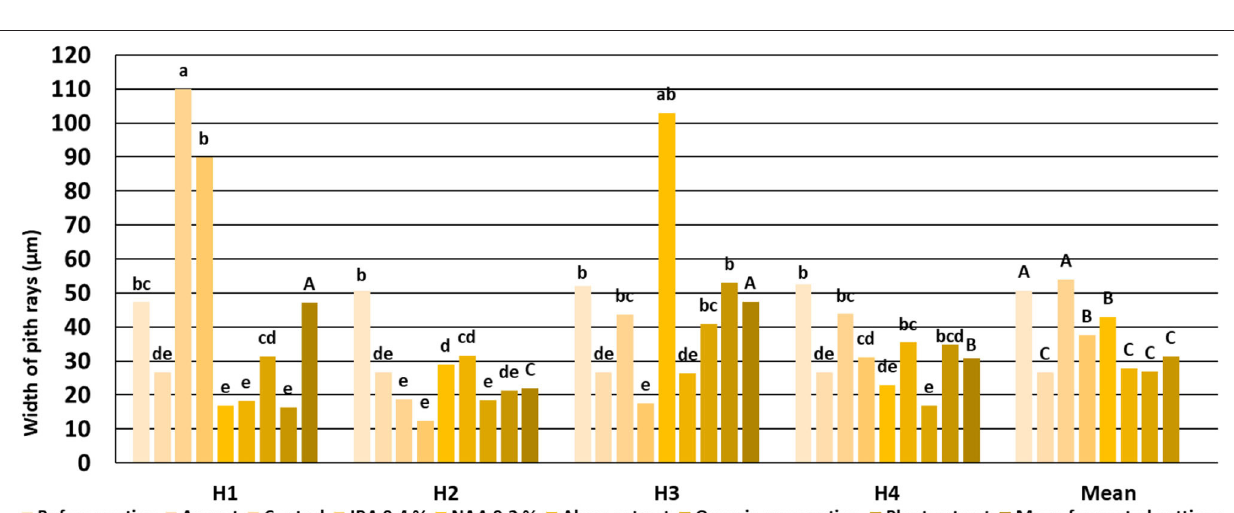
FIGURE 5 | Width of Rosa “Hurdal” pith rays in stems before rooting; cuttings after 24 days of the rhizogenesis process; and stems of stock plants cut in first days of August. Control—the control cuttings; IBA, 0.4%—Ukorzeniacz A aqua (0.4% IBA); NAA, 0.2%—Ukorzeniacz B aqua (0.2% NAA); Algae extract—watering with 0.6% Bio Rhizotonic (10ml) after planting and 10 and 20 days later; Organic preparation—watering with 0.4% Root Juice TM (10ml) after planting; Plant extract—watering with 0.02% Bio Roots (10ml) after planting. H1 − 54 504 (flower buds still closed); H2 − 69 605 (full flowering; at least 50% of flowers open); H3 − 69 629 (end of flowering of the second-order stem—all petals have fallen); H4 − 70 701 [fruit set: beginning of hip (berry) growth on the main stem]. Different small letters indicate significant interactions between the phenological stage and treatment (two-way ANOVA). Different capital letters indicate significant differences between phenological stages. Duncan’s test ( α = 0.05) was